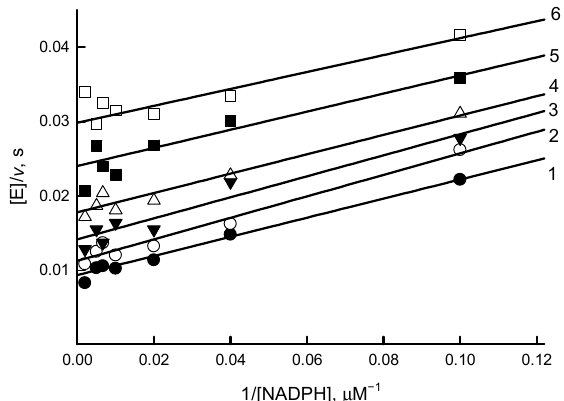
Figure 3. Lineweaver–Burk plot of the steady state kinetics of oxidation of NADPH catalyzed by Rp FNR in the presence of juglone. Juglone concentrations are 200 µM (1), 133 µM (2), 89 µM (3), 59 µM (4), 39 µM (5), and 26 µM (6).